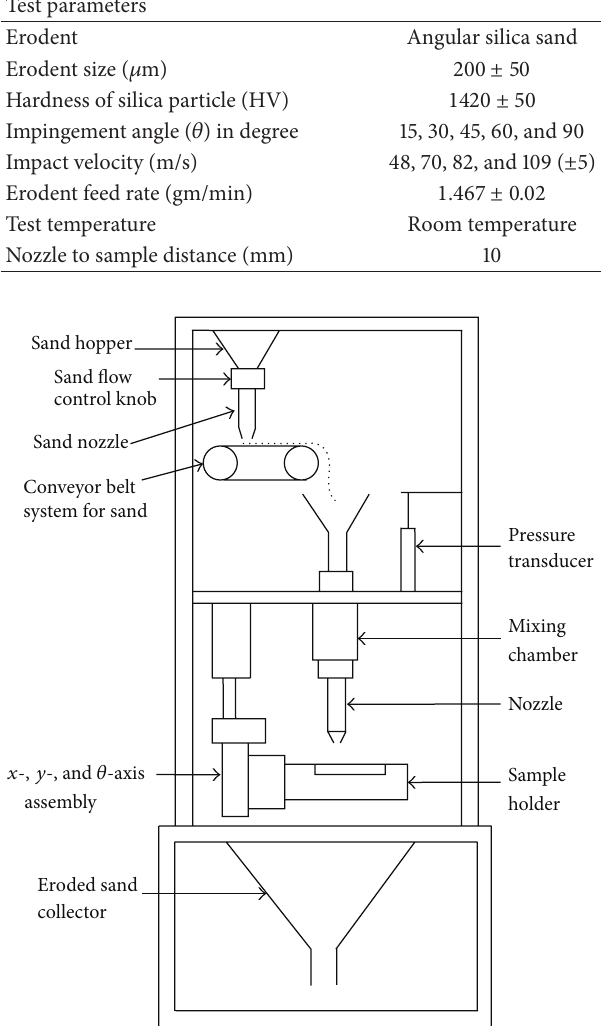
Figure 1: Schematic diagram of erosion test